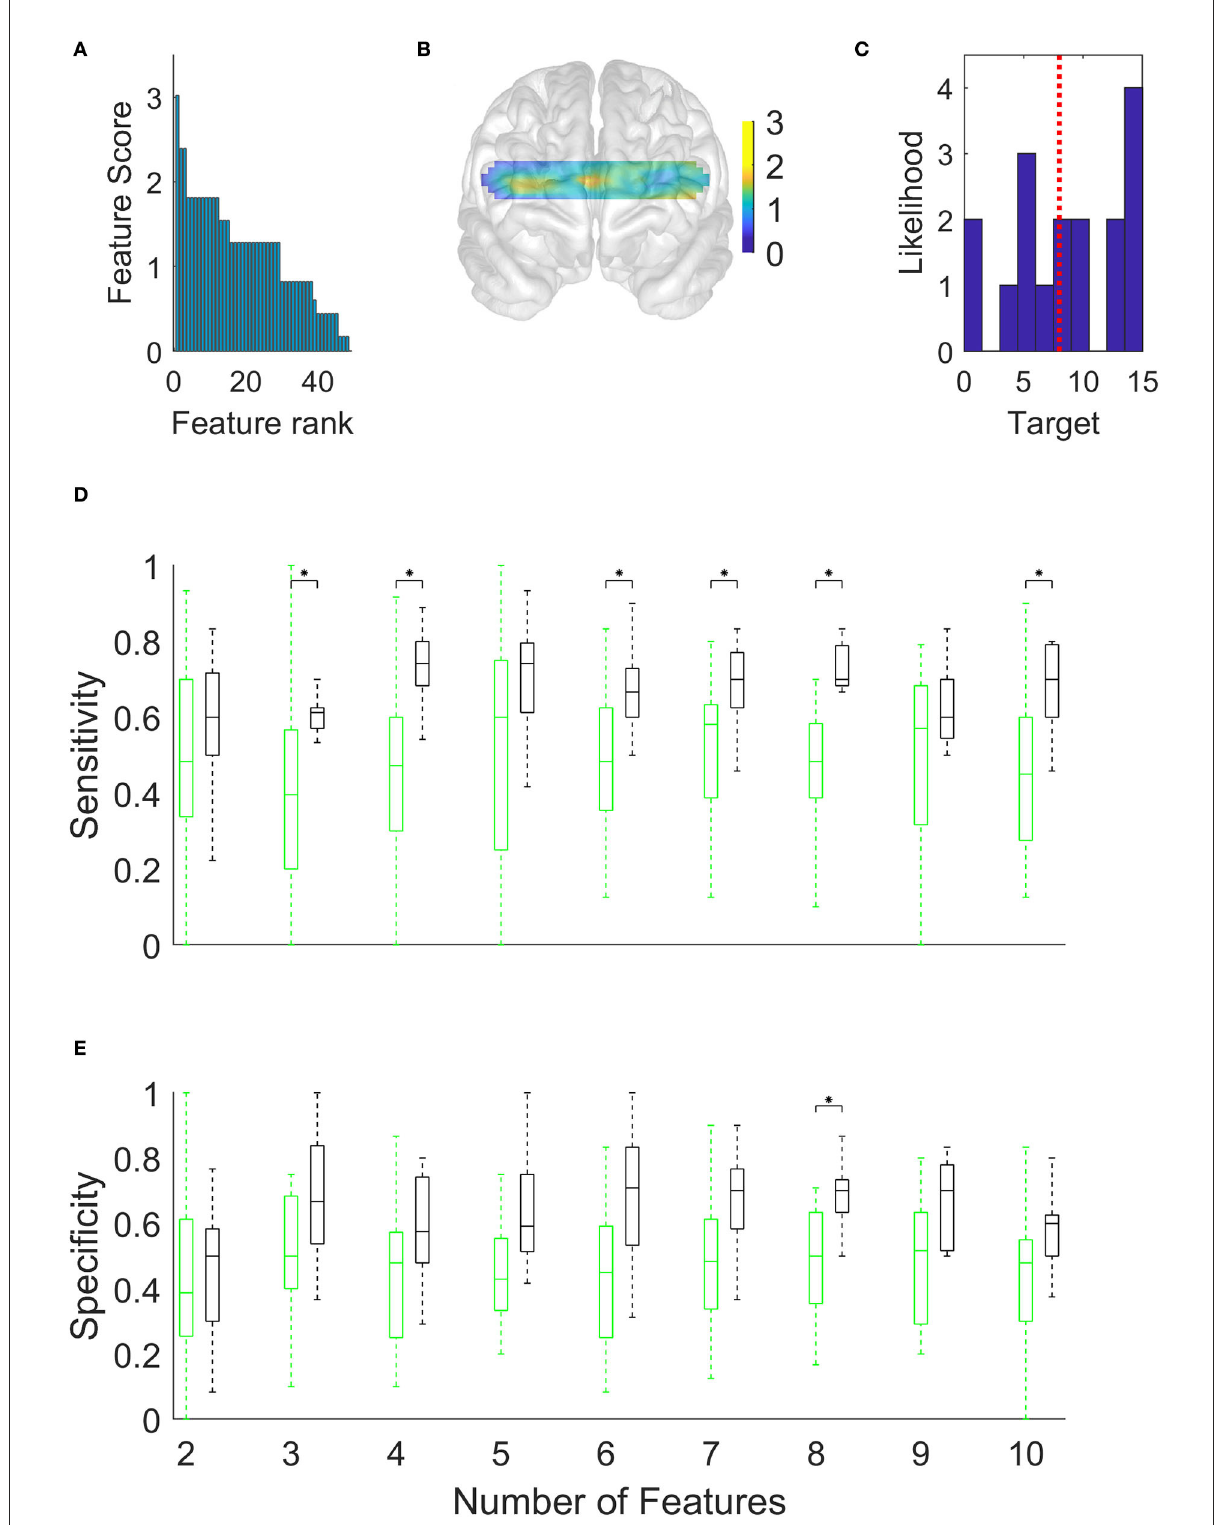
FIGURE5 Discrimination of high-scoring patients (N = 8) from low-scoring patients (N = 9) in the Verbal Memory Total Score Recall/15, using the Support Vector Machine and a limited number of the top-ranked hemodynamic features. (A) Hemodynamic feature priority scores calculated using chi-squared tests. (B) Topographic distribution of feature scores. (C) Histogram of Boston Naming Test scores of patients. The dotted red line shows the median score used to distinguish high-scoring patients from low-scoring patients. (D) Sensitivity of discriminating high-scoring patients. (E) Specificity (*p < 0.05, Bonferroni